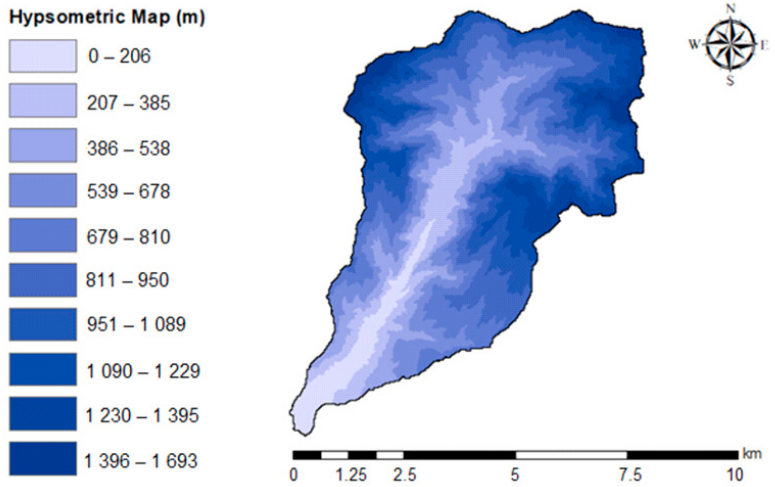
Water 2021 , 13 , x FOR PEER REVIEW Figure 5. Hypsometric map—DEM file (Source: Authors by ESRI ArcGIS, 2020). Figure 5. Hypsometric map—DEM file (Source: Authors by ESRI ArcGIS, 2020).